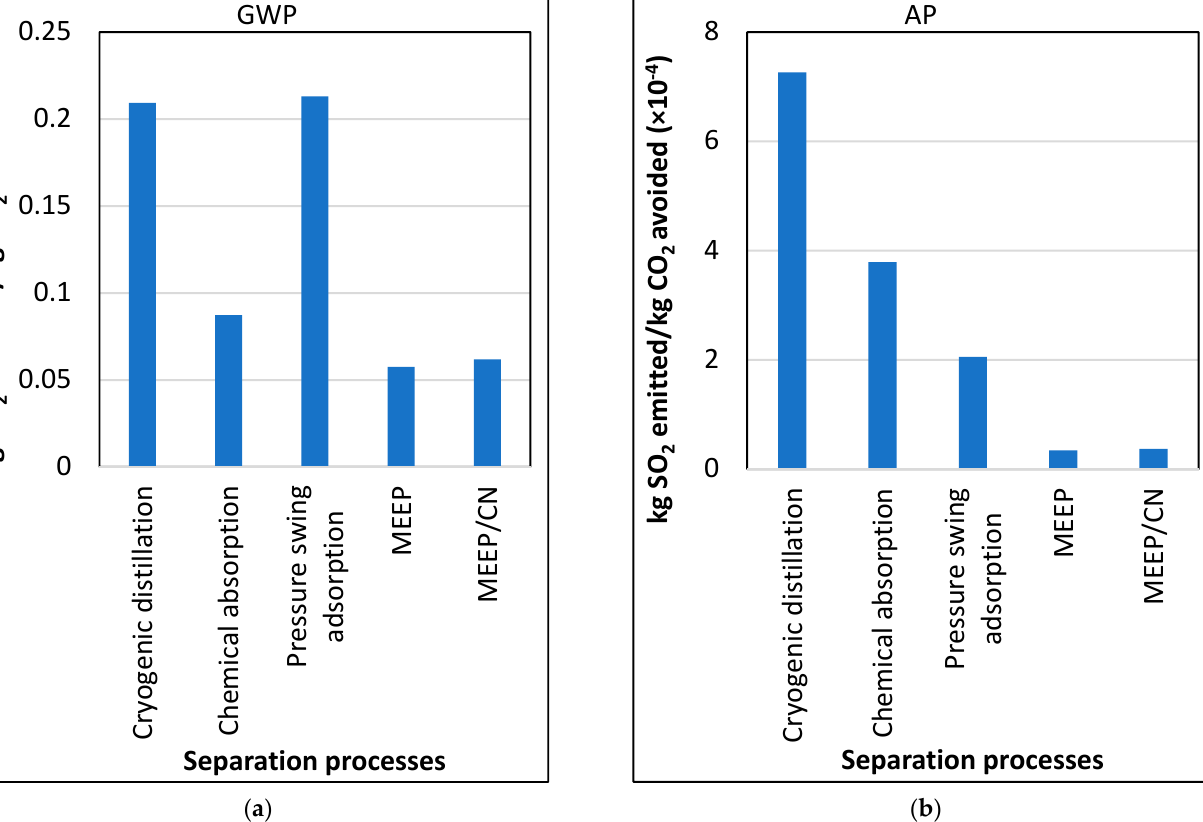
Figure 6. ( a ) Comparison of GWP of CCUs. ( b ) Comparison of AP of CCUs.